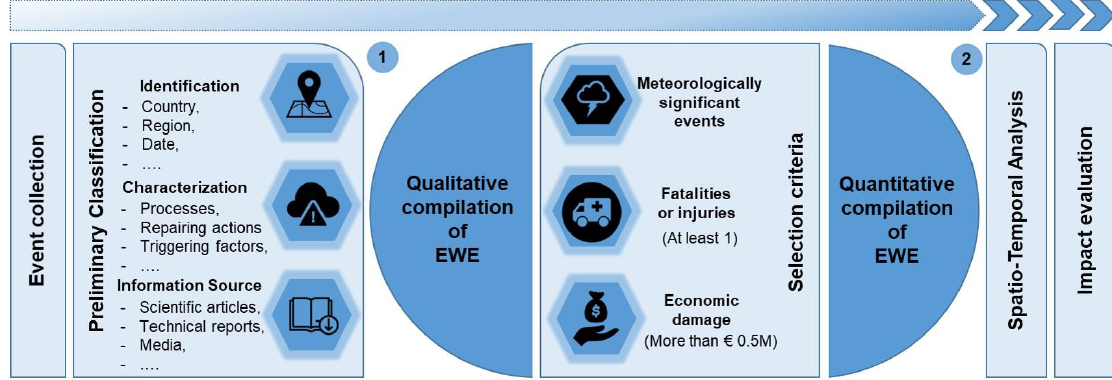
Figure 2. Methodology used for the present work with the different stages.